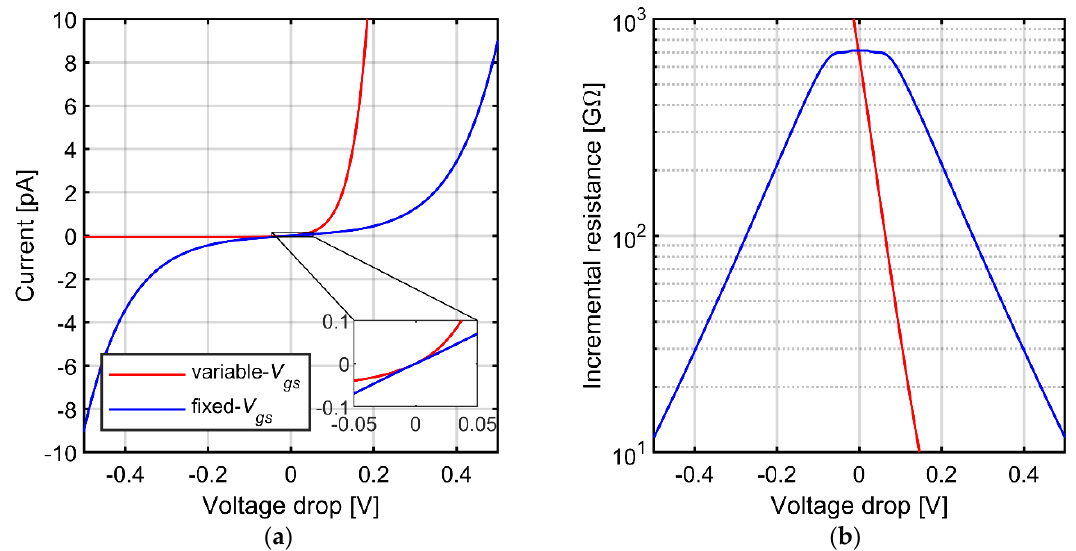
Figure 2. ( a ) Simulated current-voltage relationship for variable- V gs and symmetric fixed- V gs pseudoresistors ( b ) Incremen- tal resistance for both implementations.